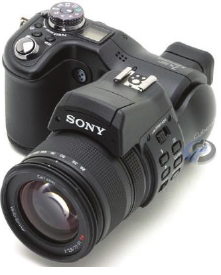
Figure 4: The Sony F828 digital camera